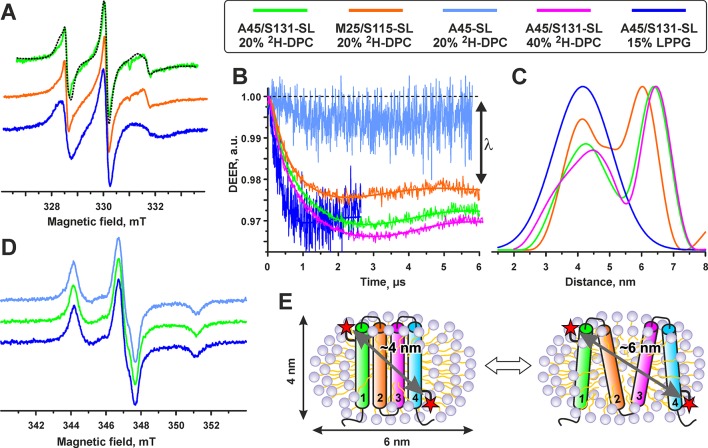
Electron paramagnetic resonance data reveal partial unfolding of spin-labeled voltage-sensing domain II variants in DPC micelles. (A) X-band CW EPR spectra of the A45/S131-SL and M25/S115-SL VSD-II variants in 20% d
38-DPC and 15% LPPG at 300 K. The dashed line shows a simulated spectrum obtained assuming a mixture of the free spin-label (8%) with the isotropic motion with τc = 0.4 ns and of the spin-label attached to the protein (92%) having anisotropic motion with τc = 1 ns. (B) Distance measurements in single- and double-spin labeled VSD-II variants in different membrane-mimicking media (see legend above the figure). Background-corrected four-pulse Q-band DEER traces are shown with normalized intensity. Solid lines show the best fits obtained using DeerAnalysis2013. (C). Interspin distance distributions obtained from the analysis of the DEER traces. In all cases, the regularization parameter L is set to 1,000. (D) X-band CW EPR spectra of the A45/S131-SL and A45-SL variants of VSD-II at 140 K. The spectra of the M25/S115-SL variant are identical and are not shown in the figure. (E) Cartoon depicting folded and partially unfolded VSD-II in complex with a DPC micelle.